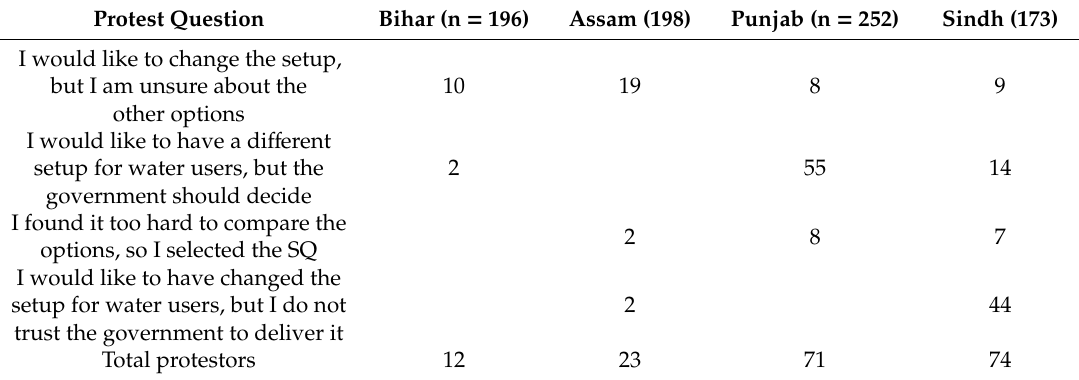
Table 10. Number of “protest” respondents, and reasons given for behaviour, by region.